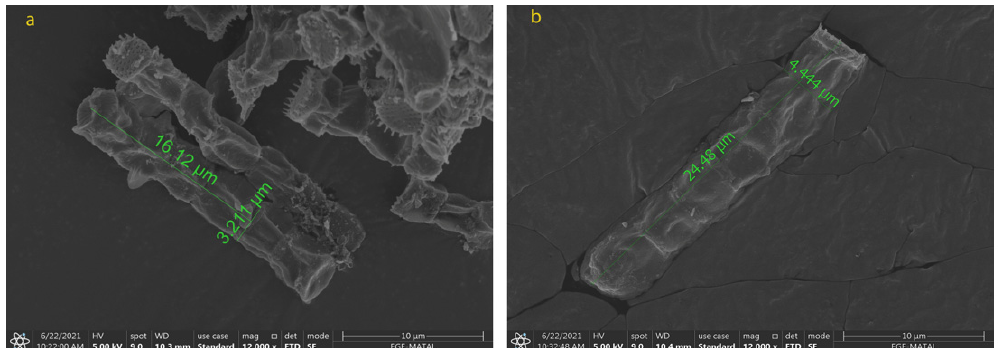
Figure 6. Morphological changes of N. shiloi in response to oxidative stress ( a ) no . OH and 1 O